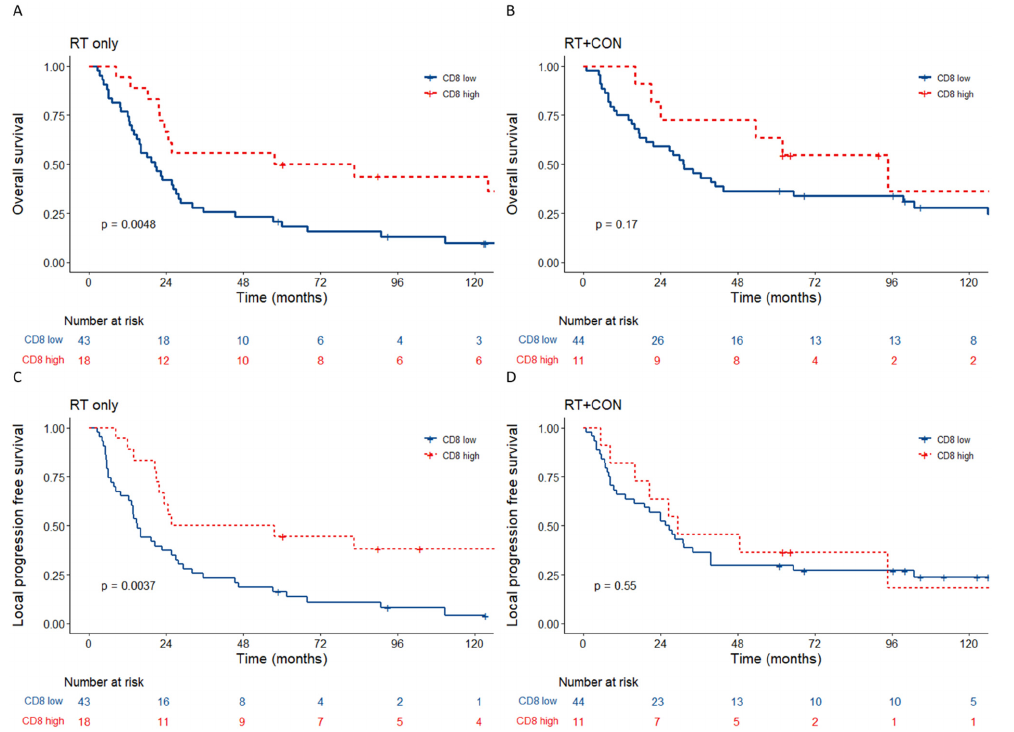
Figure 2. Kaplan–Meier plots for the treatment arms of BCON according to percent CD8 T cells. p values are log-rank tests calculated as previously described. Overall survival for ( A ) RT only treatment arm and ( B ) RT+CON treatment arm according to percent CD8 low vs. percent CD8 high. Local progression free survival for ( C ) RT only treatment arm and ( D ) RT+CON treatment arm according to percent CD8 low vs. percent CD8 high.